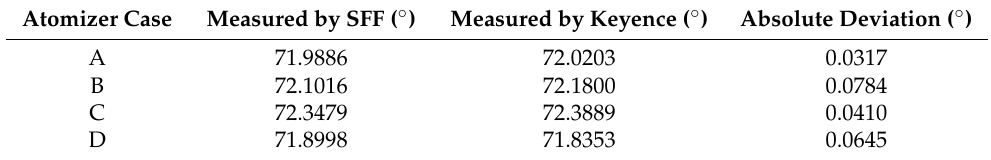
Table 3. Measurement result of semi-vertical angle.